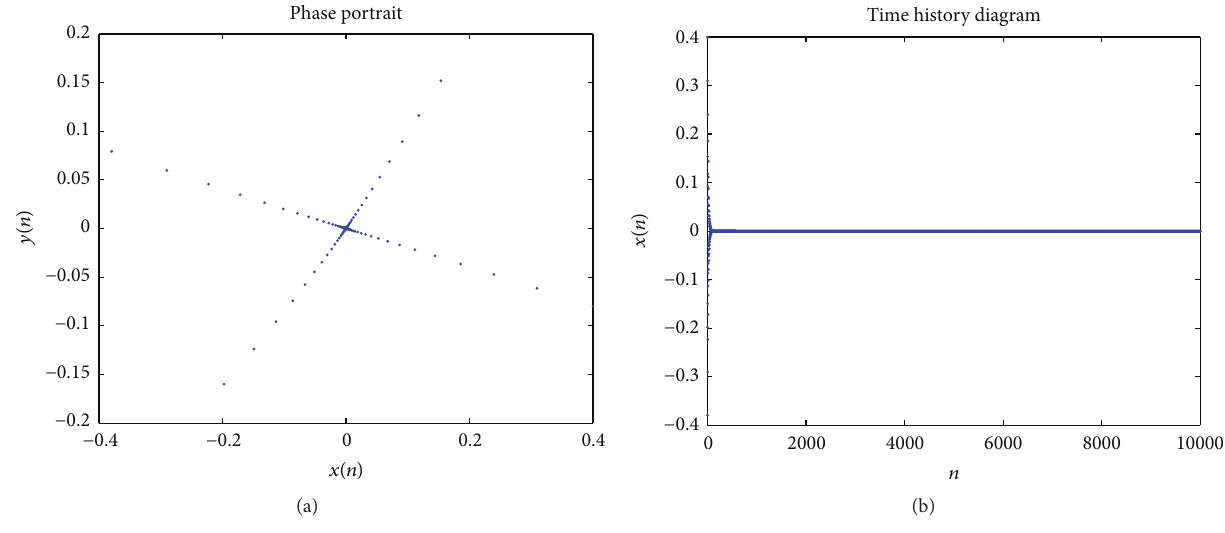
Figure 3: (a) Phase portrait and (b) time history diagram of equivalent deterministic system (6) with 𝑑 = −0.45 .